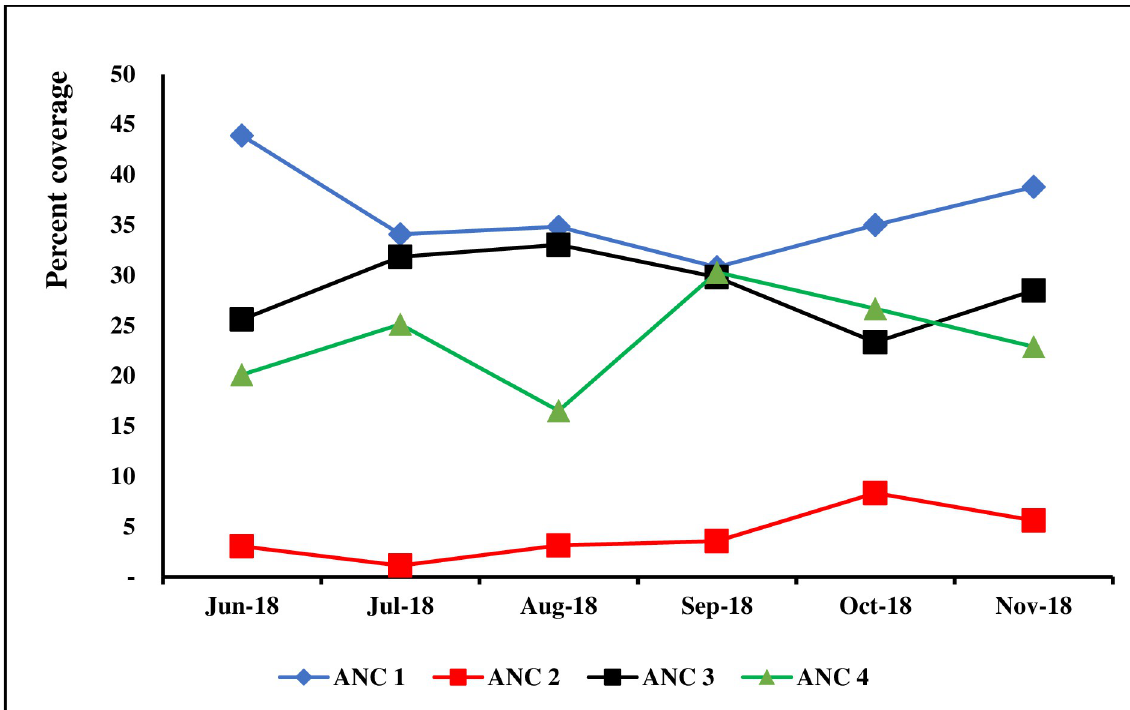
Fig 1. Baseline ANC attendance rate in Murwi Health Centre. Fig 1 is a graphical depiction of ANC attendance rates before intervention. Data on the first ANC visit (blue line), second ANC visit (red line), third ANC visit (black line) and fourth ANC visit (green line) were collected for a period of six months preceding intervention. Averages were computed and depicted on a run chart to observe the baseline trend.